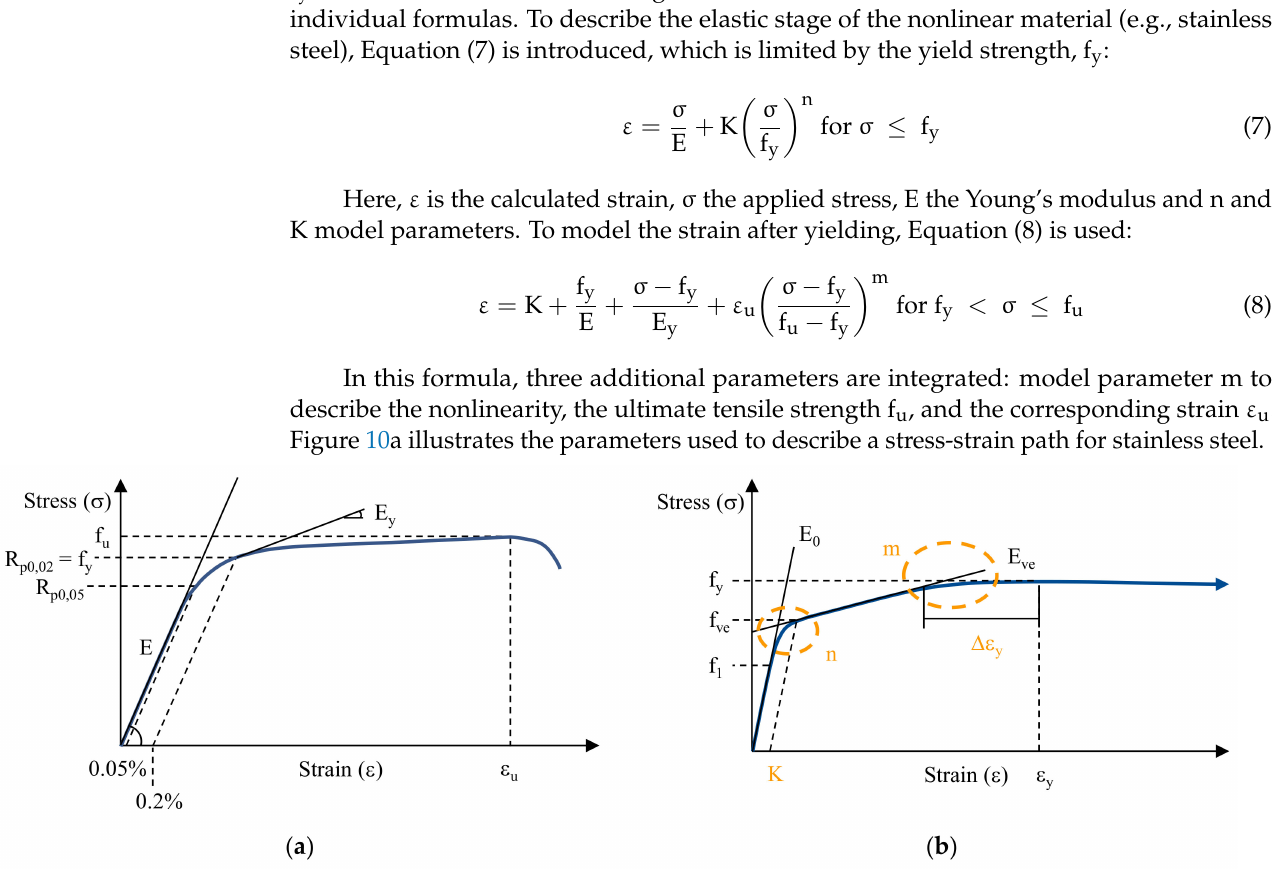
Figure 10. Stylized stress-strain curve of ( a ) stainless steel with Ramberg-Osgood parameters, follow- ing [22] and ( b ) ETFE foils with modified Ramberg-Osgood